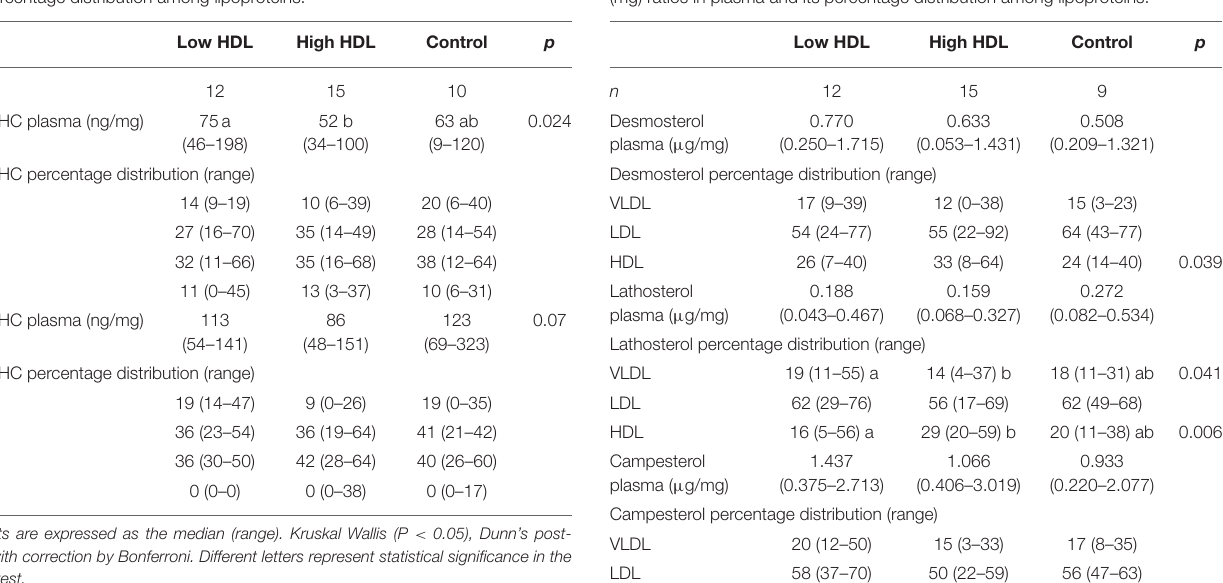
TABLE 2 | The 24-OHC and 27-OHC (ng) to cholesterol (mg) ratios in plasma and its percentage distribution among